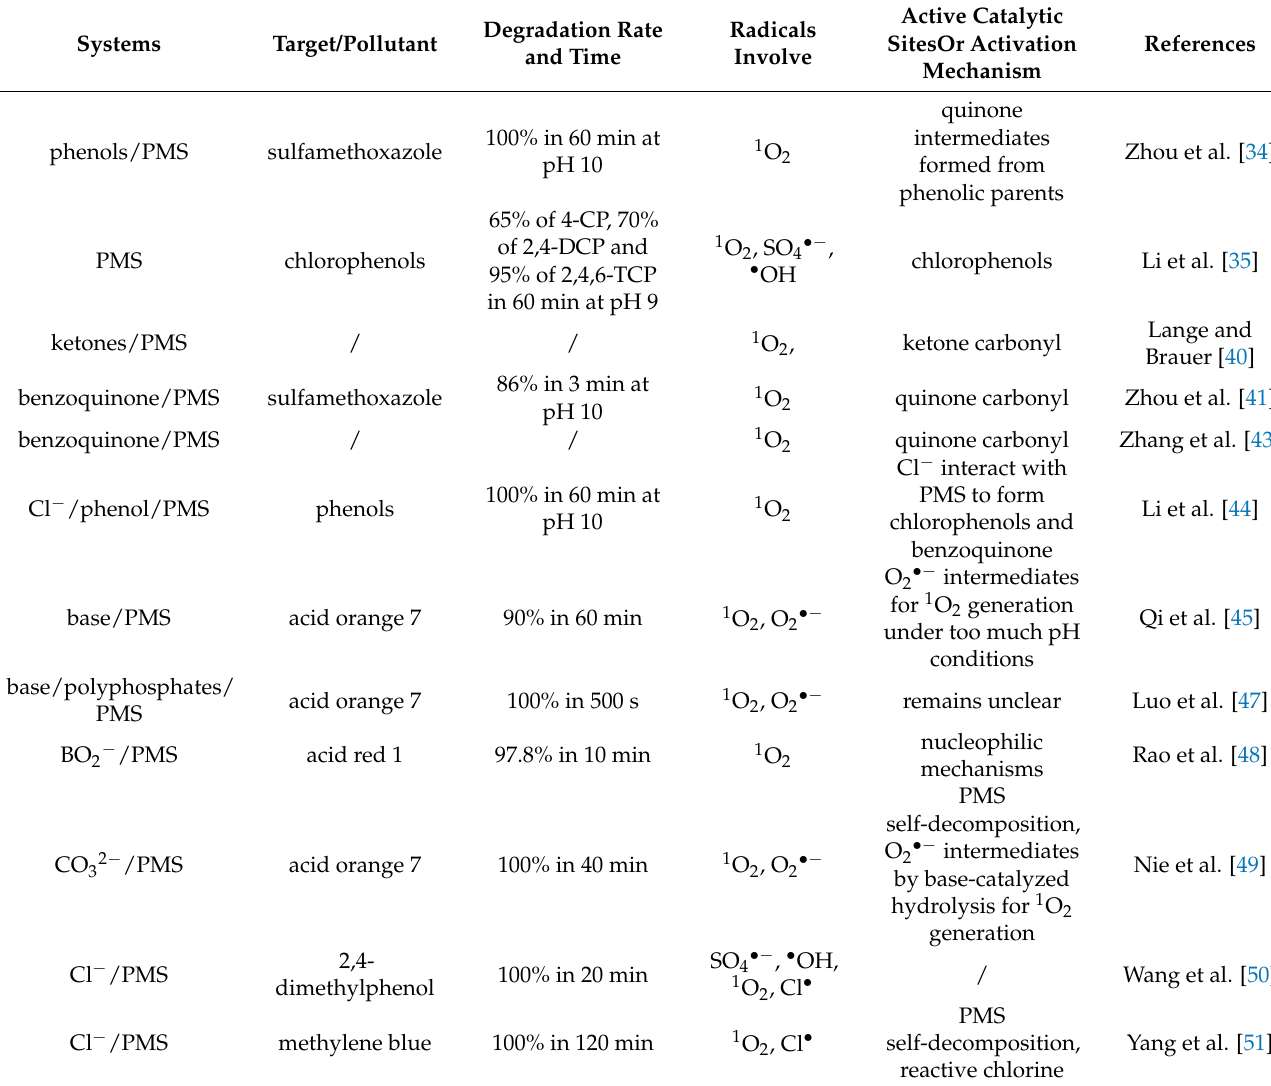
Table 1. Performance and mechanism for PDS/PMS oxidation of pollutants in typical homogenous systems.